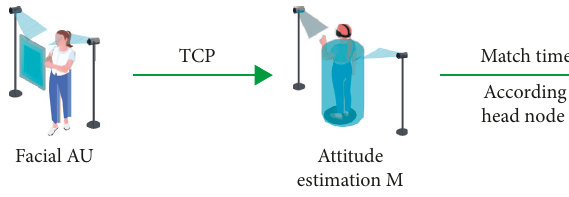
Figure 7: TCP transmission